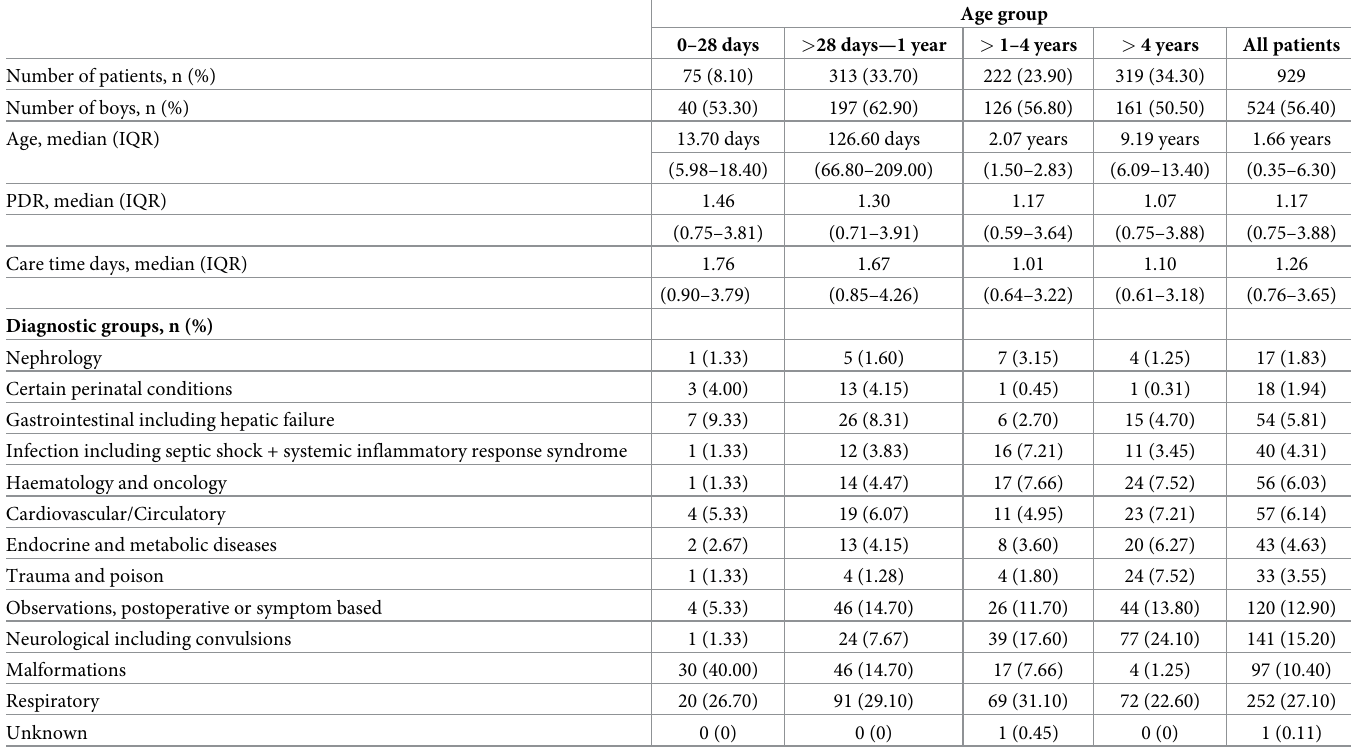
Table 3. Patient characteristics and PICU admission diagnosis by age groups: Patients with repeated admissions: Last